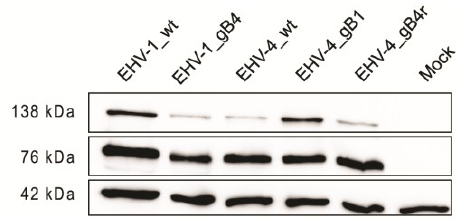
Figure 3. Expression of gB in virus-infected cells. Cell lysates were prepared from infected equine dermal (ED) cells and proteins were separated under reducing conditions by sodium dodecyl sulfate (SDS)-10%-polyacrylamide gel electrophoresis (PAGE). The blots were incubated with anti-gB monoclonal antibody (MAb)-3F6 and bound antibody detected with anti-mouse IgG peroxidase conjugate. EHV-1, EHV-4 and related recombinant virus proteins with an apparent molecular weight of approximately 130 and 76 kD were detected that are not present in mock-infected cells. Rabbit anti-β-actin antibody was used as a loading control (molecular weight of approximately 42 kDa).